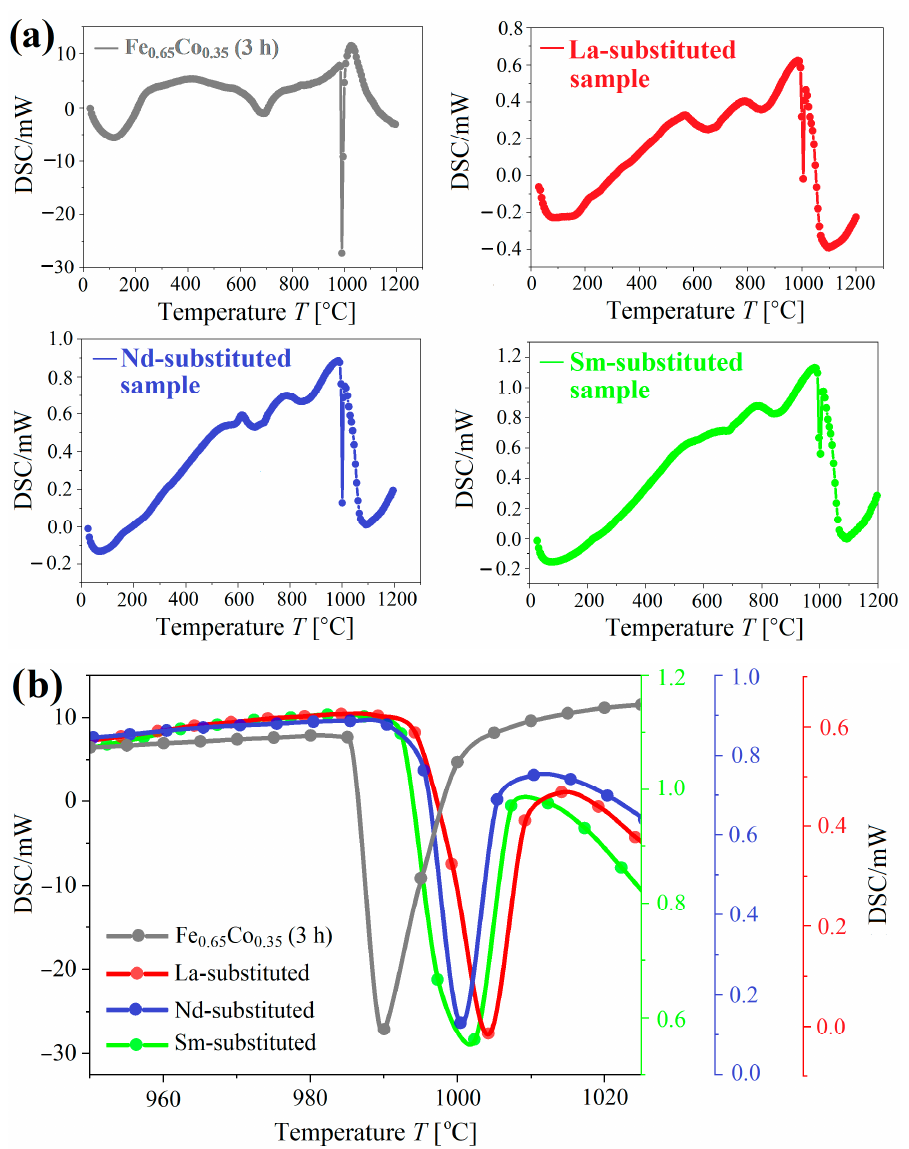
Figure 8. ( a ) The DSC curves for Fe 0.65 Co 0.35 (3 h) alloy, and (Fe 0.65 Co 0.35 ) 0.95 ( RE 2 O 3 ) 0.05 samples with RE = La, Nd, and Sm, mechanically alloyed for 3 h in the mechanosynthesis process during effective high-energy ball milling. ( b ) The sharp peaks in all alloys related to the transition from body-centered cubic (bcc) ferromagnetic to the face-centered cubic (fcc) paramagnetic structure (range 950 – 1040 °C)